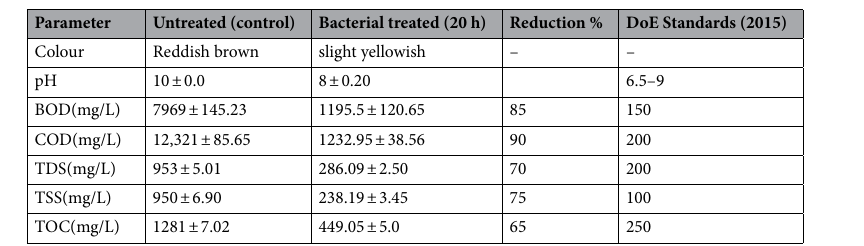
Table 1. Physico-chemical analysis of the effluent before and after the bacterial treatment. Values are mean of three experiments ± standard deviation (SD).